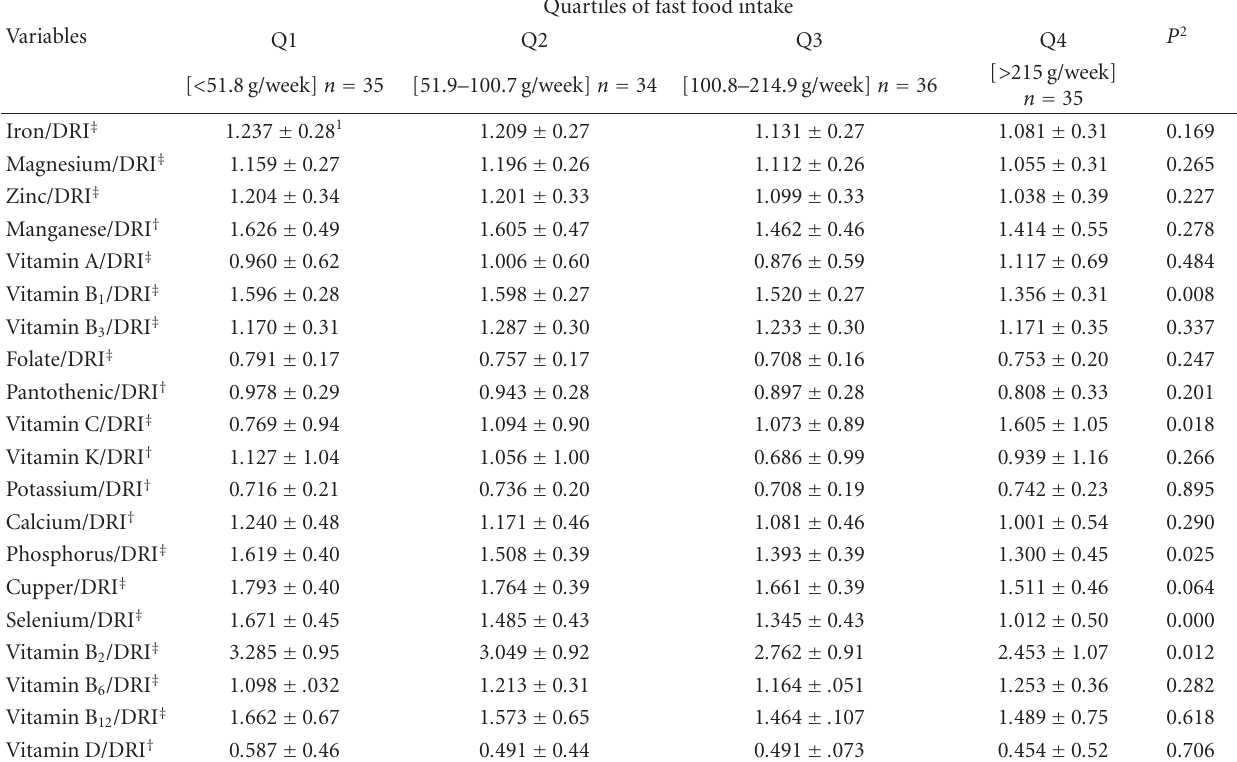
Table 3: Energy-adjusted distribution of nutrient adequacy ratio across fast food consumption quartiles.